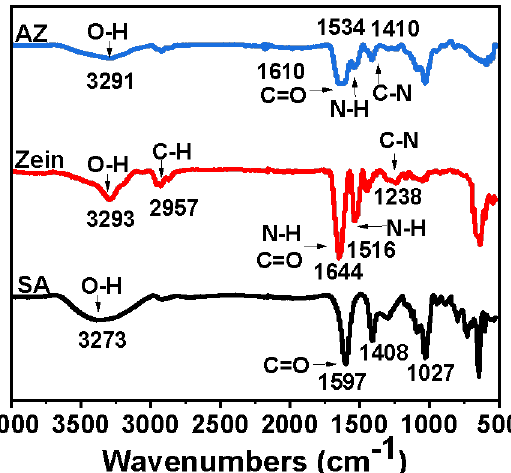
Figure 2. FTIR spectra of alkali-treated zein (AZ), zein, and sodium alginate (SA).